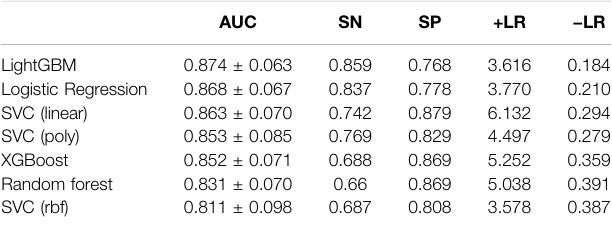
TABLE2| Comparisonbetweendifferentmachinelearningmodelsvalidatedby5- fold validation. AUC